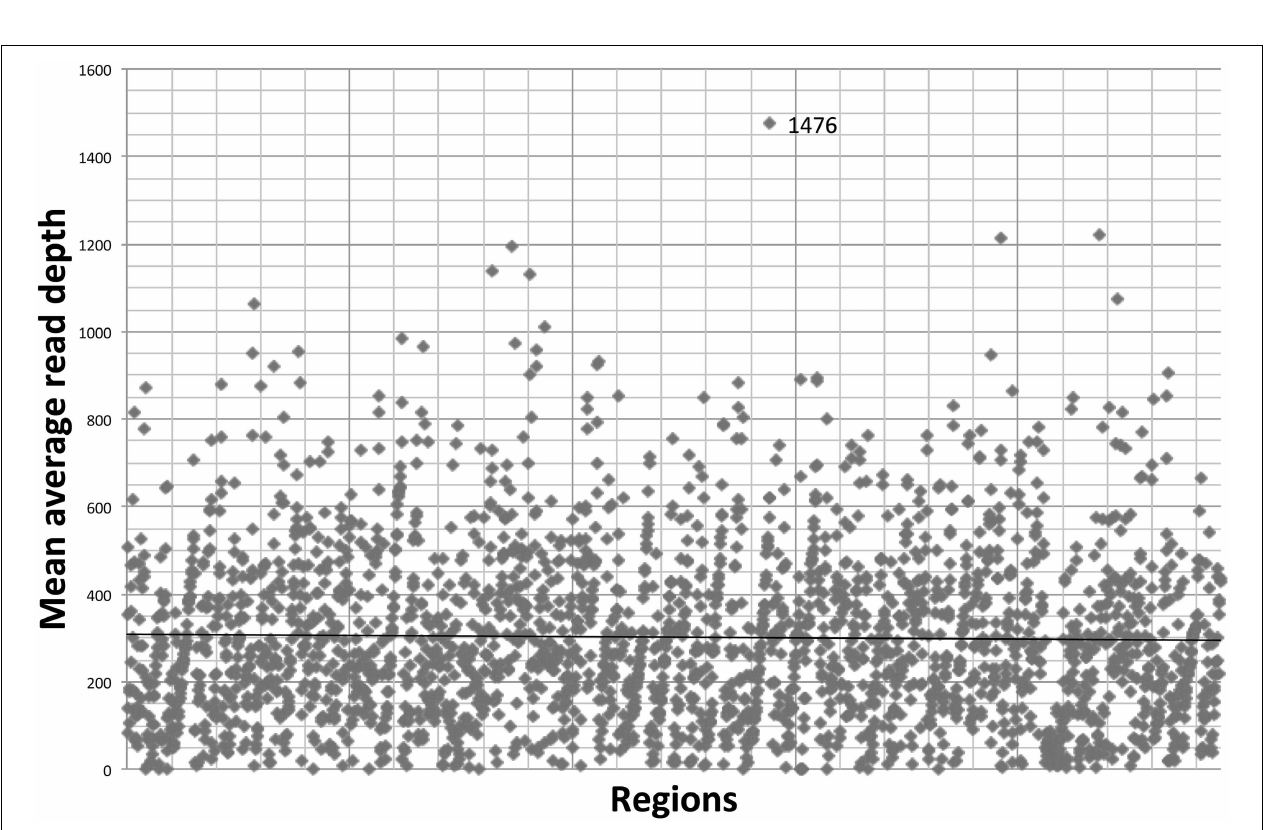
expected) (expected/actual): HLA-DRB5 (83/29), TNFRSF13C (100/80), UNC93B1 (95/84), CD79A (100/89), NCF4 (100/89). The region-by region coverage analysis for 33 samples run using